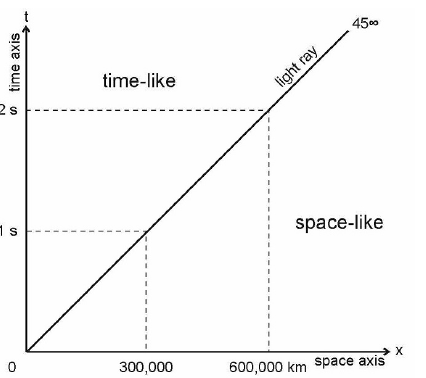
Figure 6. Structure of spacetime where one second of time along time axis equals 300,000 km along the space